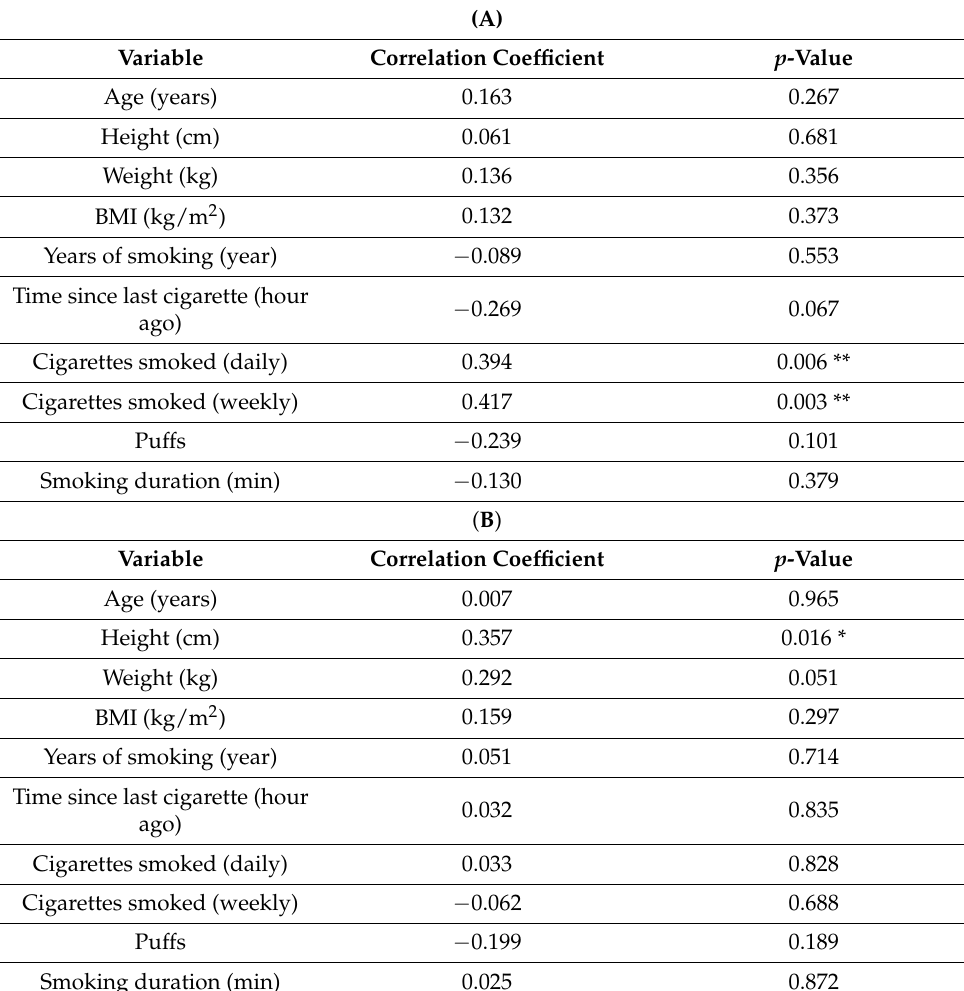
Table 3. ( A ). Correlation of baseline exhaled CO concentration with demographics, physiological and smoking habits in smokers. ( B ). Correlation of exhaled CO half-life with demographics, physiological and smoking habits in